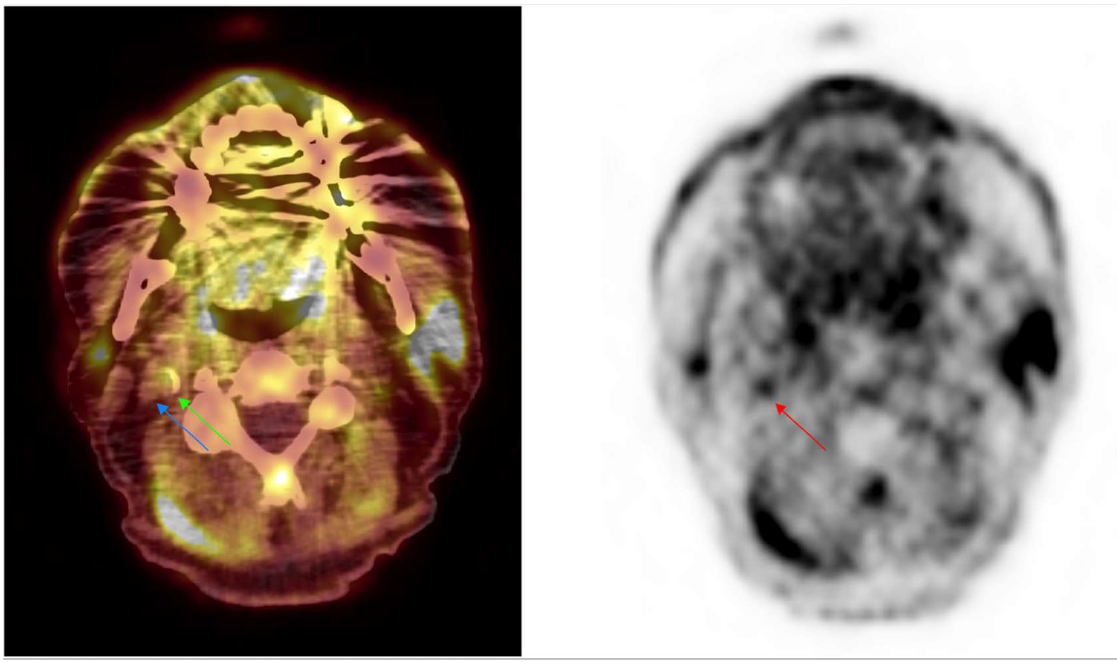
Figure 3. Incidental findings from atherosclerosis in [ 18 F]FMCH PET/CT imaging. Axial [ 18 F]FMCH PET/CT performed in a 66 year old patient to assess prostate adenocarcinoma disease. Images showed an intense focal uptake (red arrow) on PET imaging with an hyperdensity on PET/CT (green arrow) corresponding to an atherosclerosis plaque with mineralization from the right internal carotid. The internal vein is shown (blue arrow).